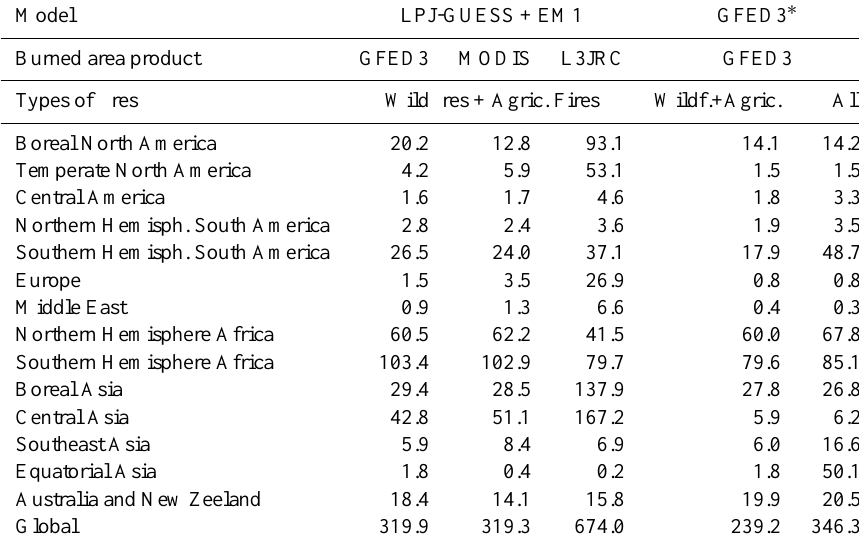
Table 3. Average annual CO emissions inTg 2001–2006 with LPJ-GUESS and Emission Model 1 using different remotely sensed burned area products: GFED3 (Giglio et al., 2010), L3JRC (Tansey et al., 2008), and MODIS MCD45 (Roy et al., 2005). Last 2 columns